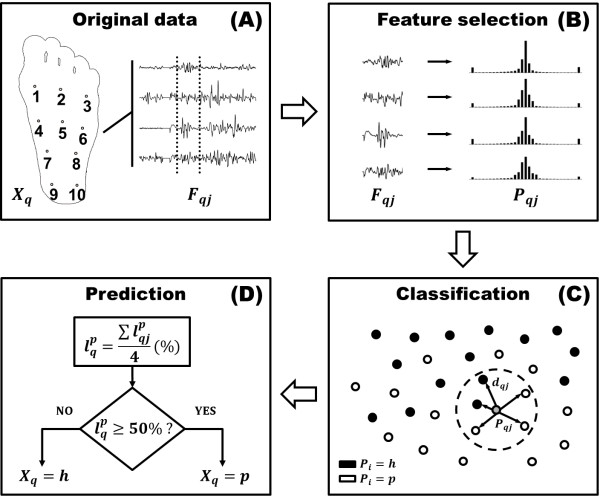
Scheme of the proposed probabilistic prediction model. (A) Given a query subject Xq ∈ TE, a set of EMG signals Fqj,j=1,4¯ are obtained as a response to repeated electrical stimulation of ten sites on the sole of the foot. (B) A probability distribution histogram Pqj is constructed from each signal Fqj (or combination of signals from multiple sites) to be used as classification feature. (C) The signal Fqj is labelled p (for patient) or h (for healthy), depending on the distances dqj to the closest neighbouring histograms Pi, derived from the set of training subjects {Xi ∈ TR}. (D) The final prediction for the subject Xq is carried out based on the labels lqj derived from the individual assessment of all four signals. Query subjects Xq ∈ V were used instead for all validation procedures (site combination and training set selection).